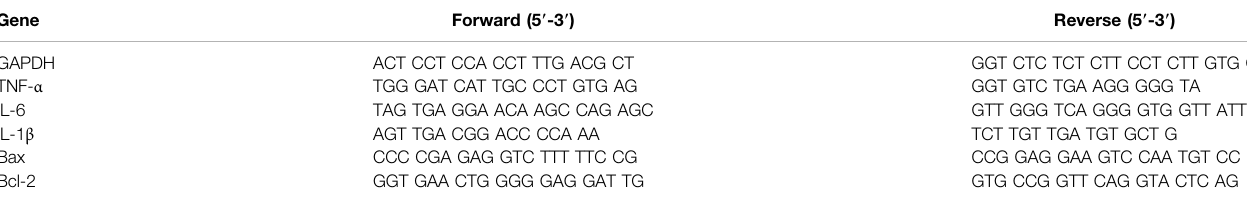
TABLE 1 | Primer sequences of each gene.